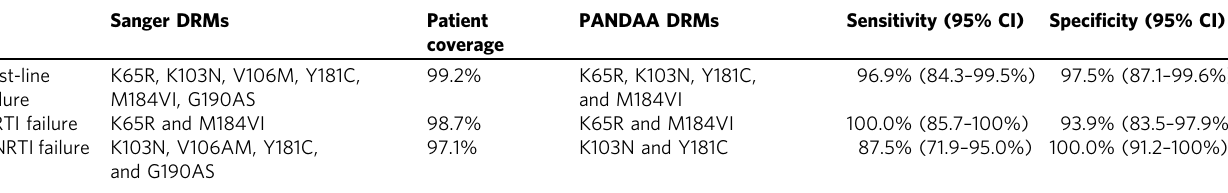
Table 4 Diagnostic sensitivity and speci fi city of PANDAA to determine fi rst-line ART and drug class-speci fi c